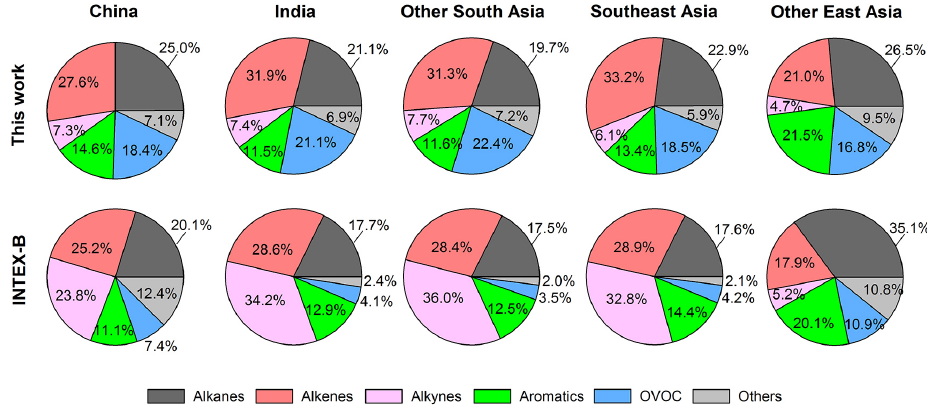
Figure 9. Distribution of anthropogenic NMVOC emissions in 2006 among different chemical groups for Asia